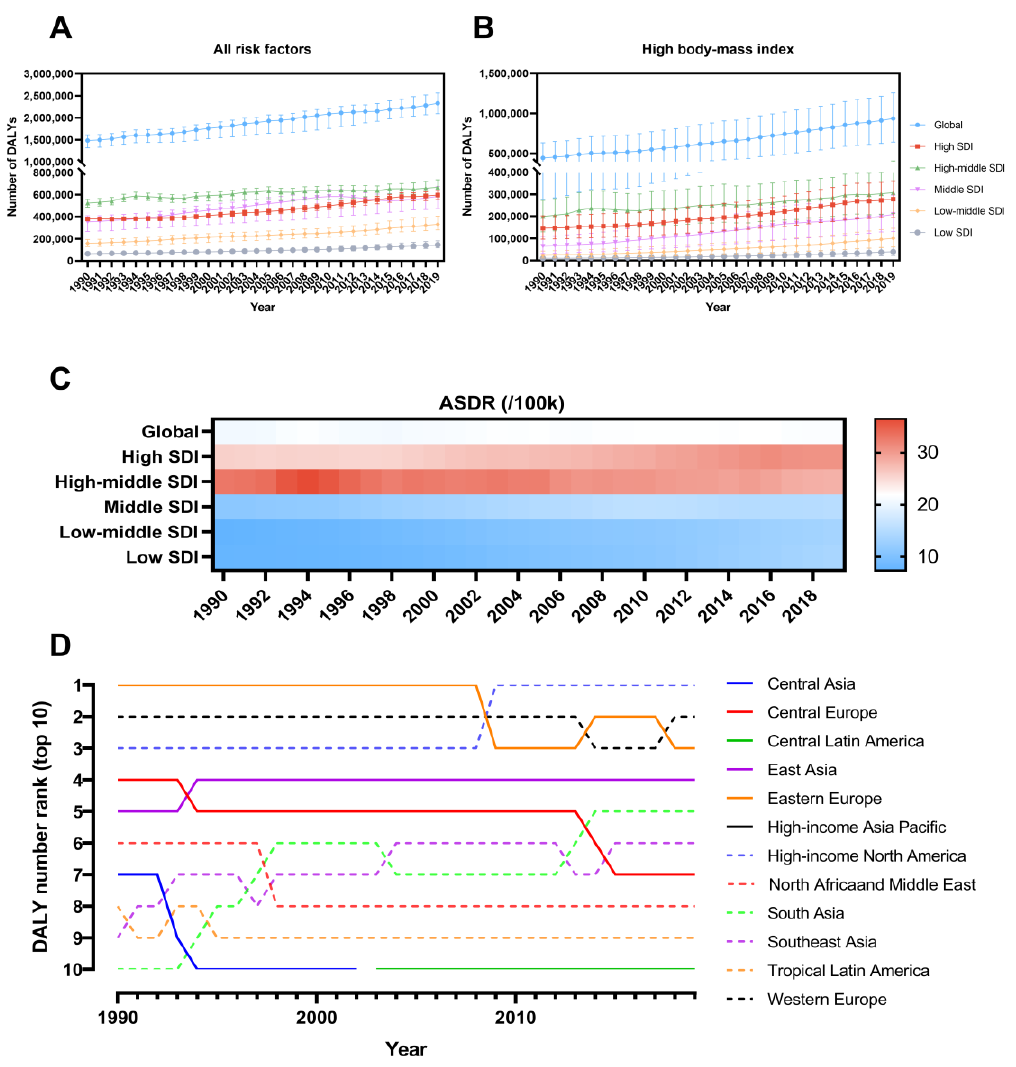
Figure 4. ( A ) Number of uterine cancer DALYs under all risk factors from 1990 to 2019. ( B ) Number of uterine cancer DALYs attributable to high BMI. ( C ) ASDR from 1990 to 2019 for global and SDI regions. ( D ) Ranking of uterine cancer DALYs attributable to high BMI in GBD regions, 1990 – 2019 (Top 1). DALY, Disability-adjusted life year; ASDR, Age-standardized DALY rate; SDI, Socio-demographic Index; GBD, Global Burden of Disease Study.